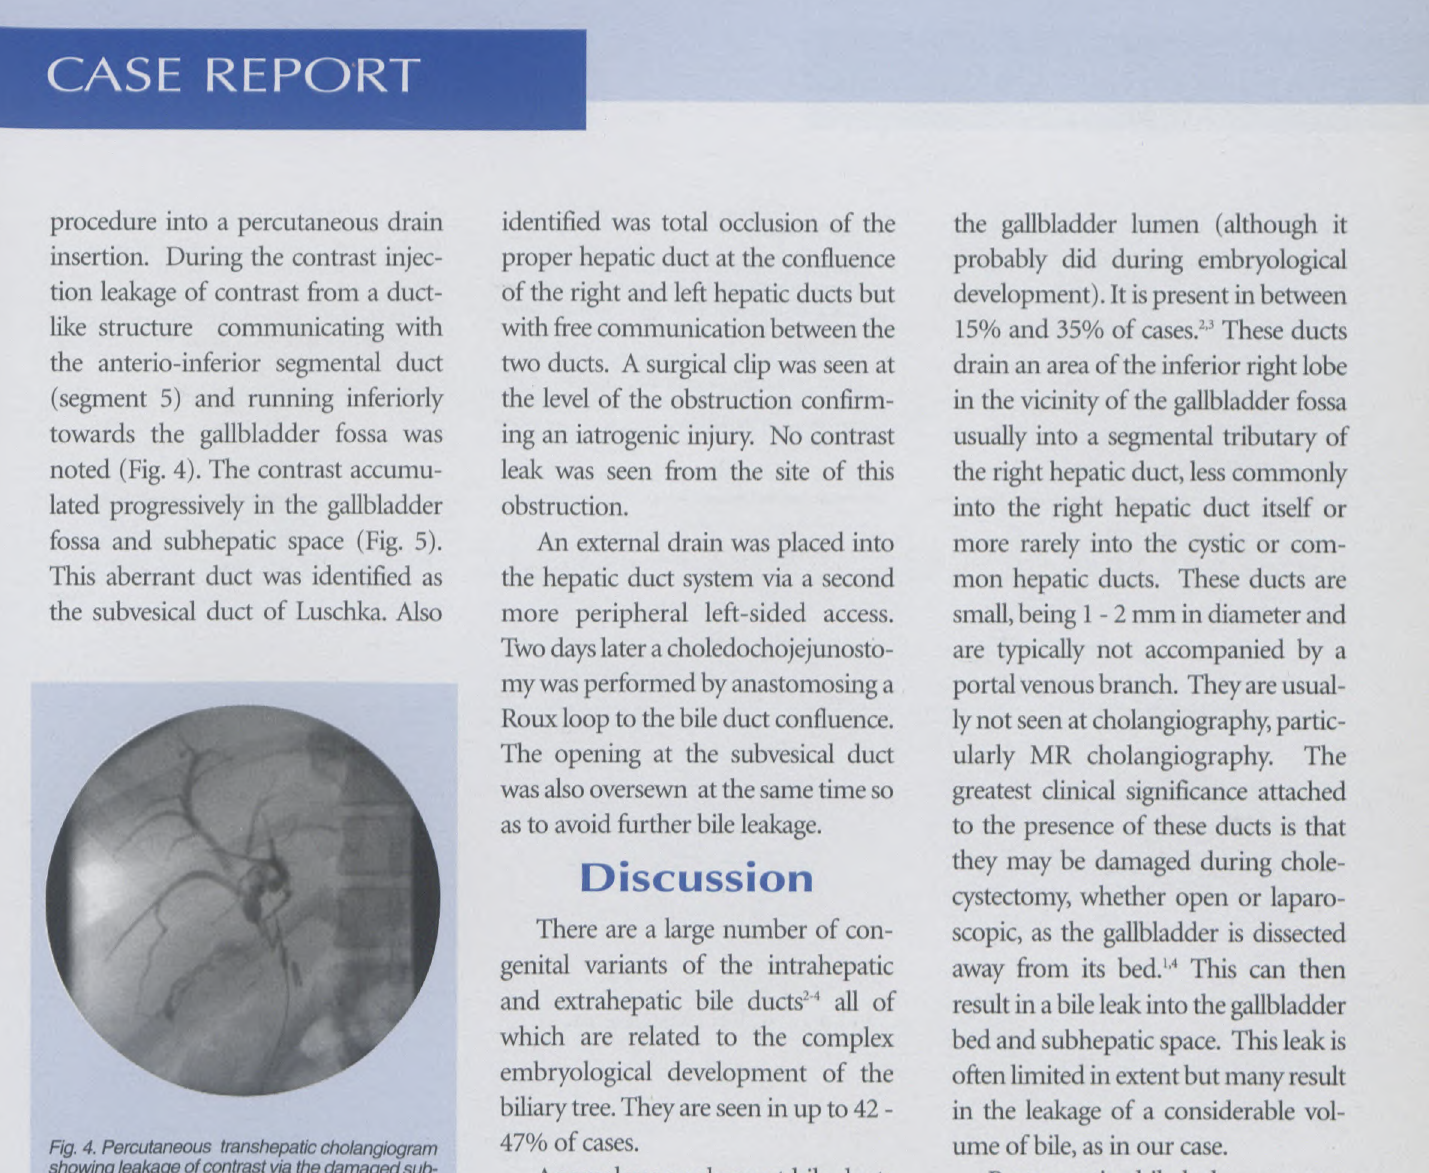
Fig. 4. Percutaneous transhepatle cholangiogram showing leakage of contrast via the damaged sub- vesical duct of Luschka communicating between the anterioinferior segmental duct and the gall- bladder fossa.